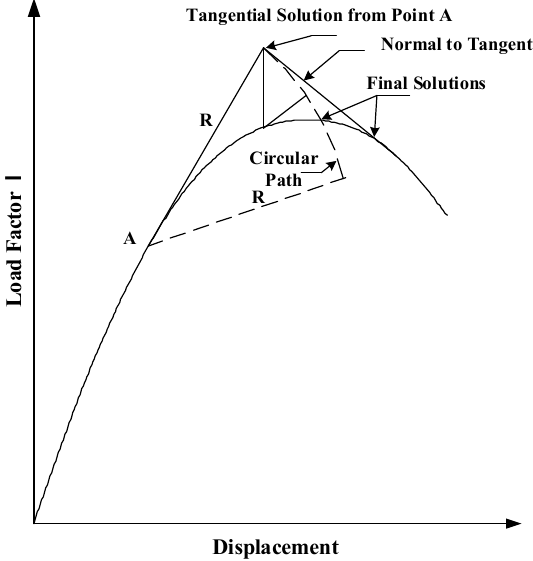
Fig. 4. Riks arc-length with Newton-Raphson technique (Riks,